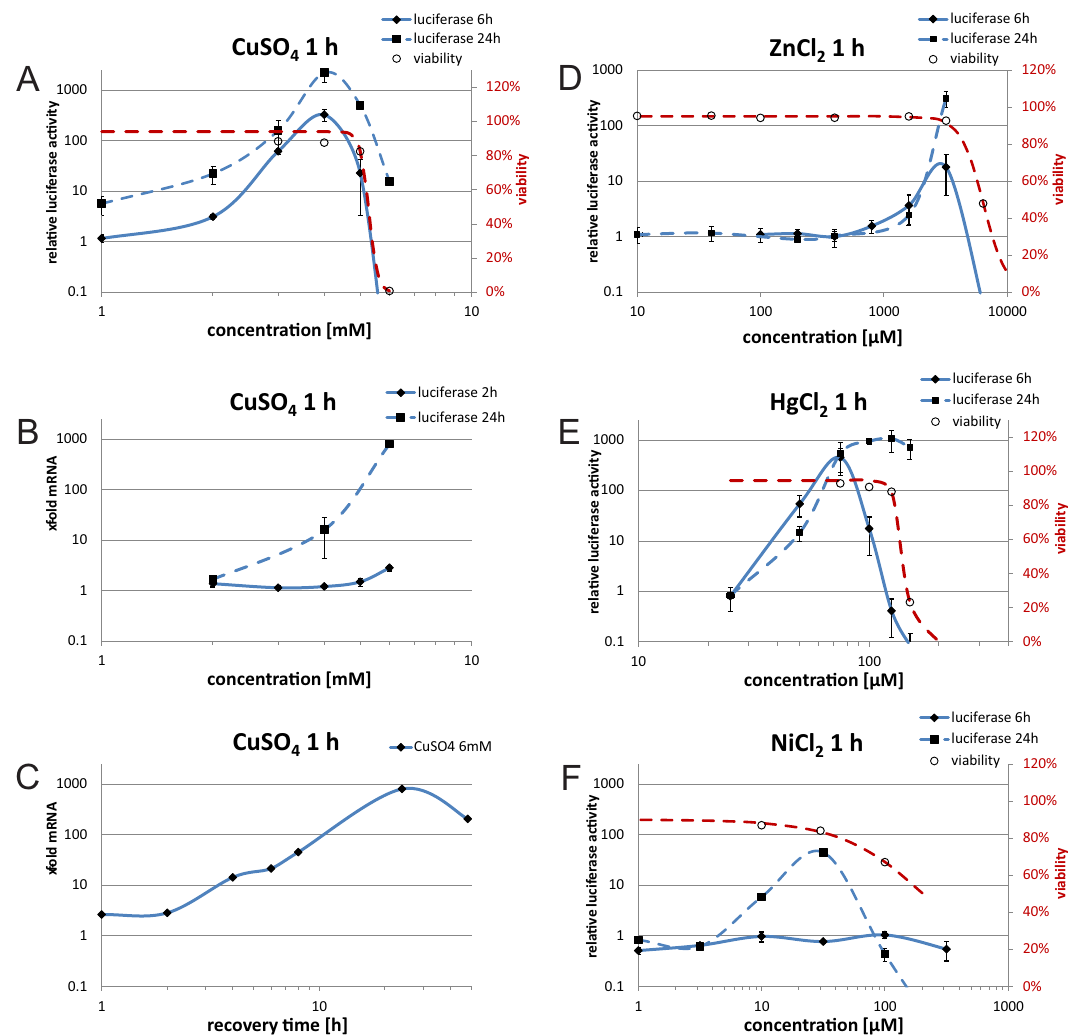
Fig 4. Analysis of C5 cells with different heavy metals. (A-C) C5 cells were treated with CuSO 4 for 1 h. Then the cells were recovered for up to 24 h. (A) Luciferase reporter assay, Y-axis shows relative luciferase activity compared to untreated control cells for 6 h and 24 h. Viability (curve fitted red dotted line, right y-axis) was measured with trypan blue. (B,C) qPCR, Y-axis shows x-fold luciferase mRNA compared to untreated control cells relative to GADPH mRNA. (B) mRNA induction after 2 and 24 h; (C) time course of mRNA induction for 6 mM CuSO 4 treatment. (D–F) Luciferase reporter assay, C5 cells were treated with different inducers for 1 h and 6 or 24 h recovery. Y-axis shows relative luciferase activity compared to untreated control cells. X-axis shows concentration of heavy metals. Viability (curve fitted, red dotted line, right y-axis) was measured with trypan blue. (D) ZnCl 2 (E) HgCl 2 (F) NiCl 2 . All values show means of at least three independent experiments. Error bars indicate SEM.